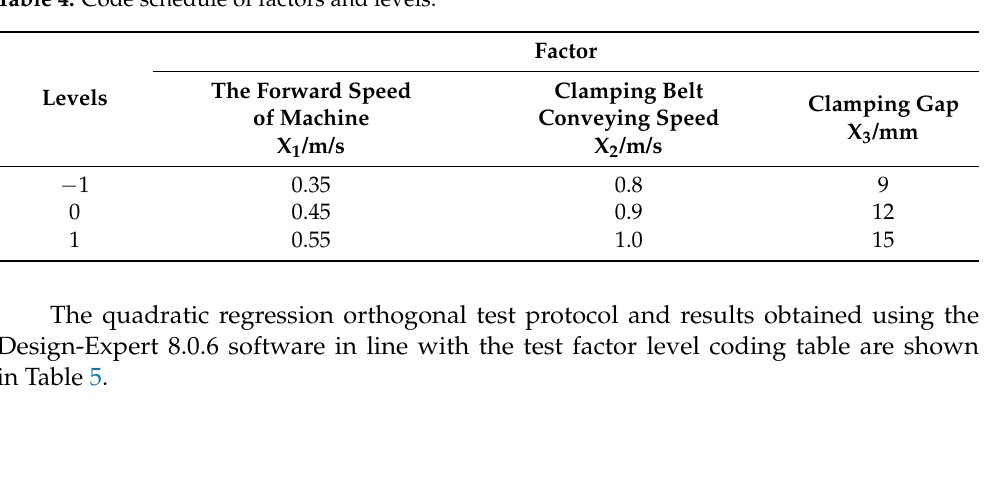
Table 4. Code schedule of factors and